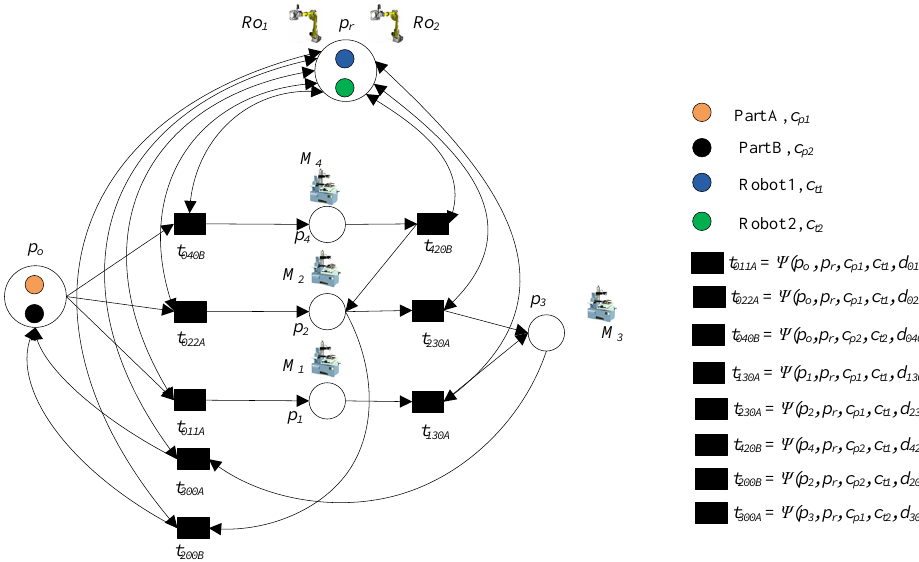
Figure 2. Intelligent colored token Petri net (ICTPN) of an AMS example, as shown in Figure 1(a).